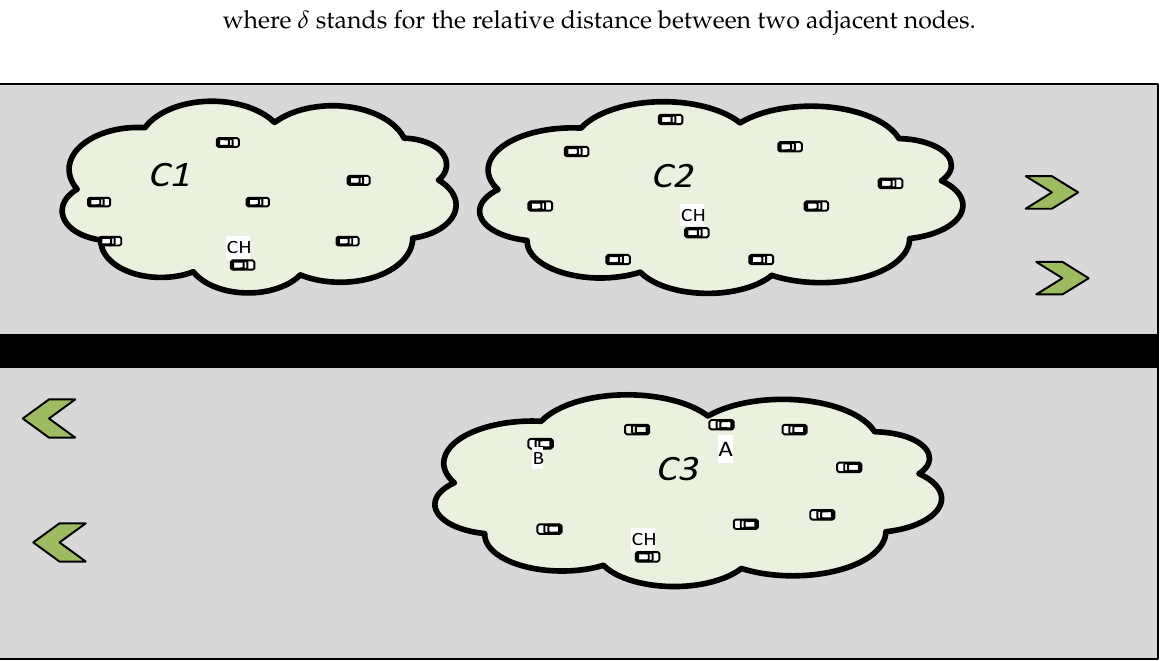
Figure 3. Cluster formation in bi-directional.